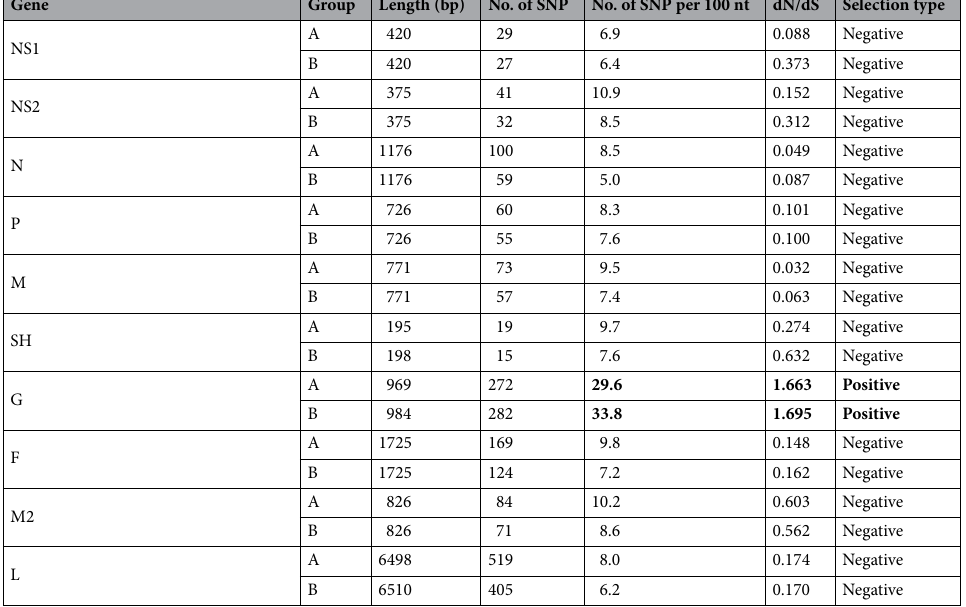
Table 1. Number of SNPs and ratios of dN/dS for each genes of theRSV-A and -Bgenomes. Numbers in bold are positive selection sites by both the MEME and FUBAR methods.